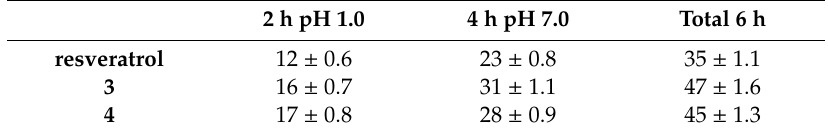
Table1. In vitrobioavailability(%)ofresveratrol, 3 and 4